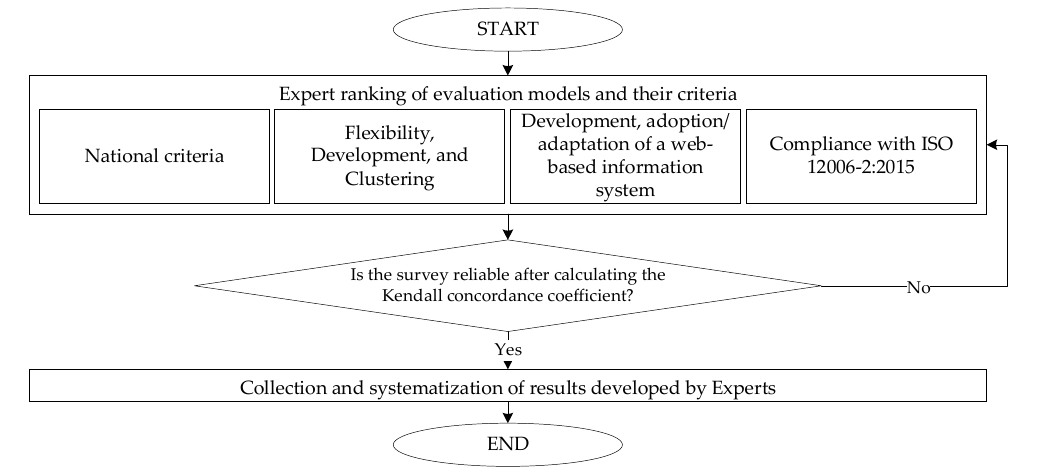
Figure 2. Schematic representation of expert ranking of evaluation models and their criteria (drawn by authors).